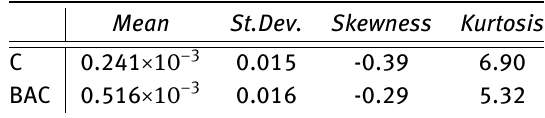
Table 1: Summary